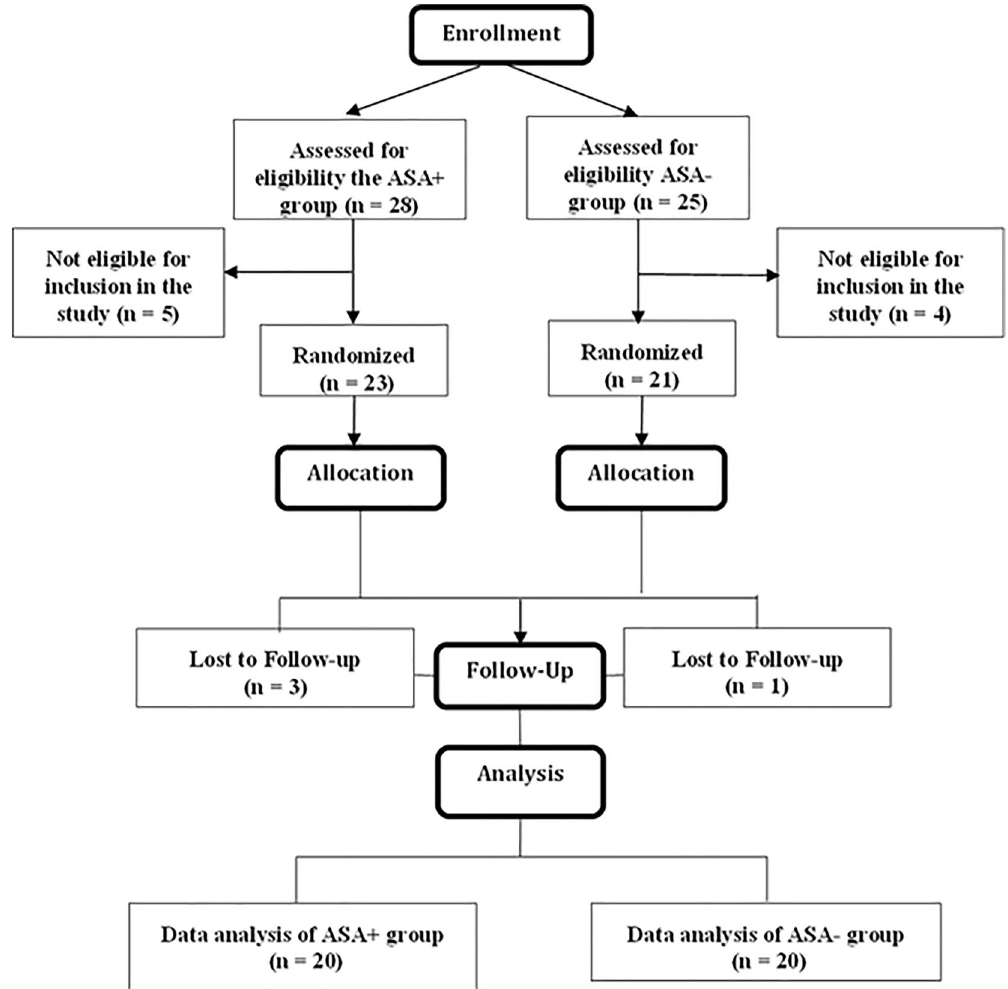
Figure 11. A flowchart of the present trial strategy. ASA−: Non-aspirin group, ASA+: Aspirin